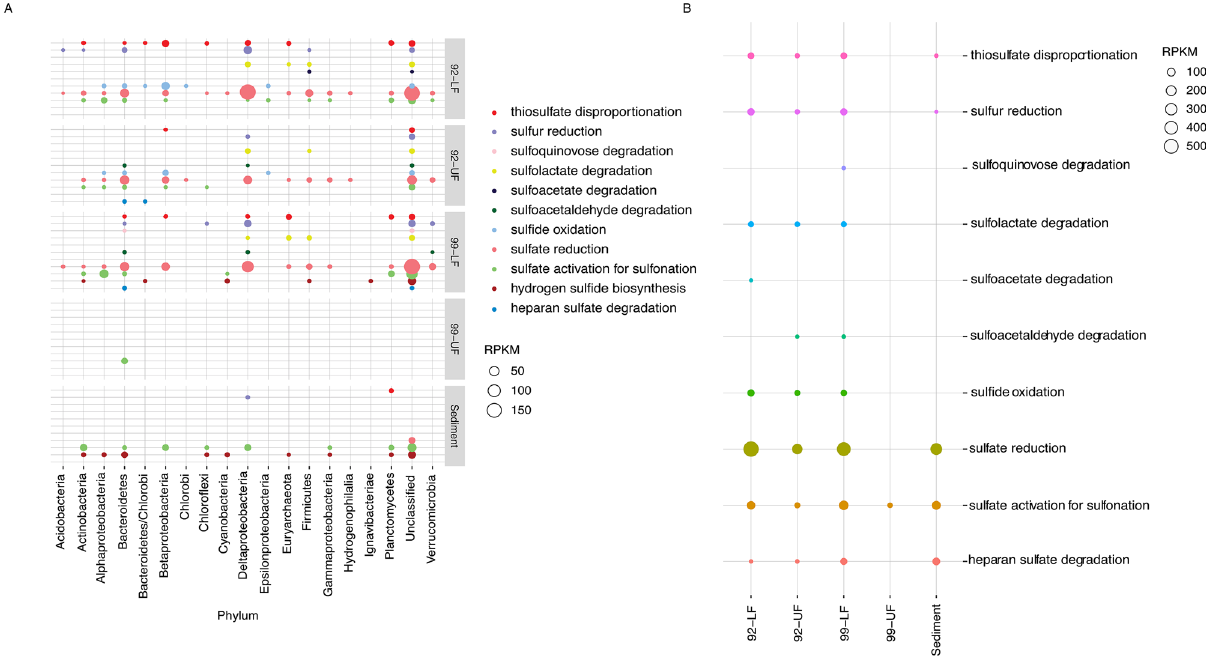
Figure 6. An overview of the sulfur metabolism pathways. ( A ) Shows the sulfur metabolism pathway abundances in the phyla. ( B ) Shows the sulfur metabolism pathways abundance in each sample. Since only 44% of the reads mapped back to the UF99 sample, not much information can be inferred from the data belonging to this sample. Sulfate reduction, the most abundant sulfur metabolism reaction, can couple with methane oxidation and facilitate the usage of methane as an energy